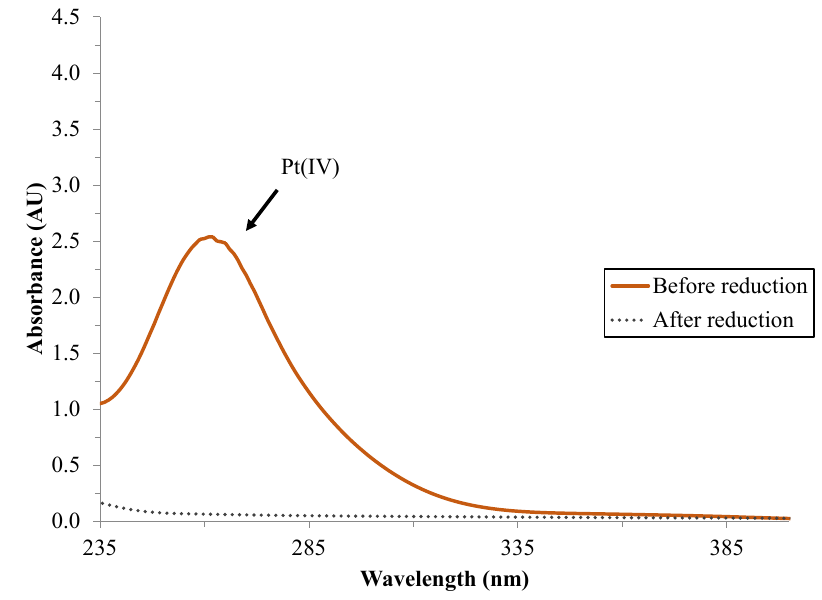
Figure 1. Absorption spectra of Pt(IV) solution and Pt sol reduced by NaBH 4